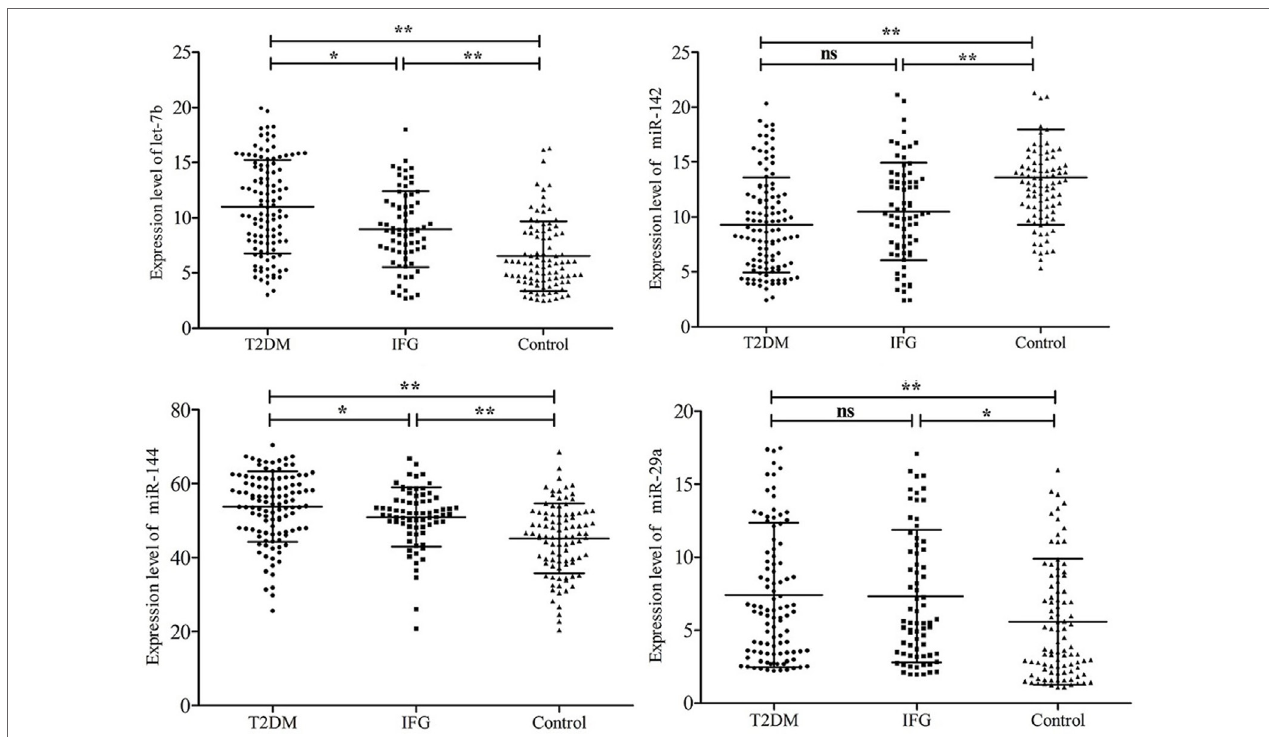
FigUre 2 | Comparison of plasma microRNAs expression based on quantitative real-time polymerase chain reaction readings among type 2 diabetes mellitus, impaired fasting glucose, and control groups. Data are represented by scatter diagram. * P < 0.05, ** P < 0.01, ns, not significant.